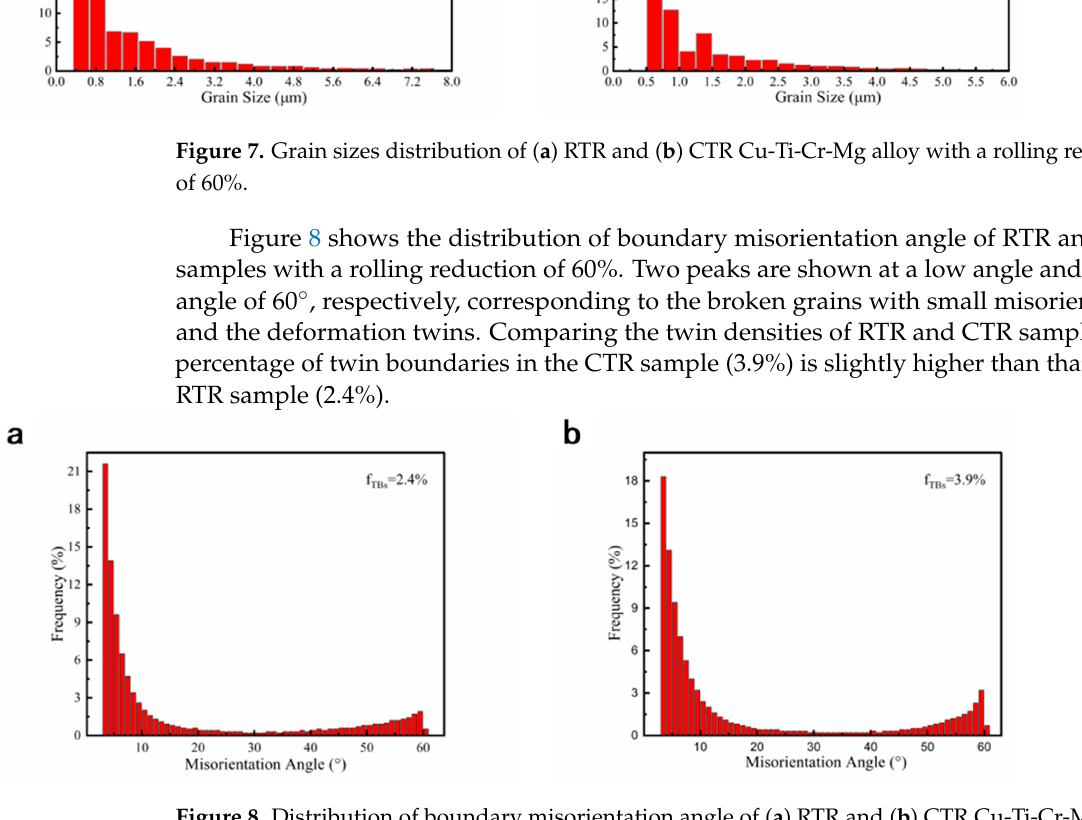
with a rolling reduction of